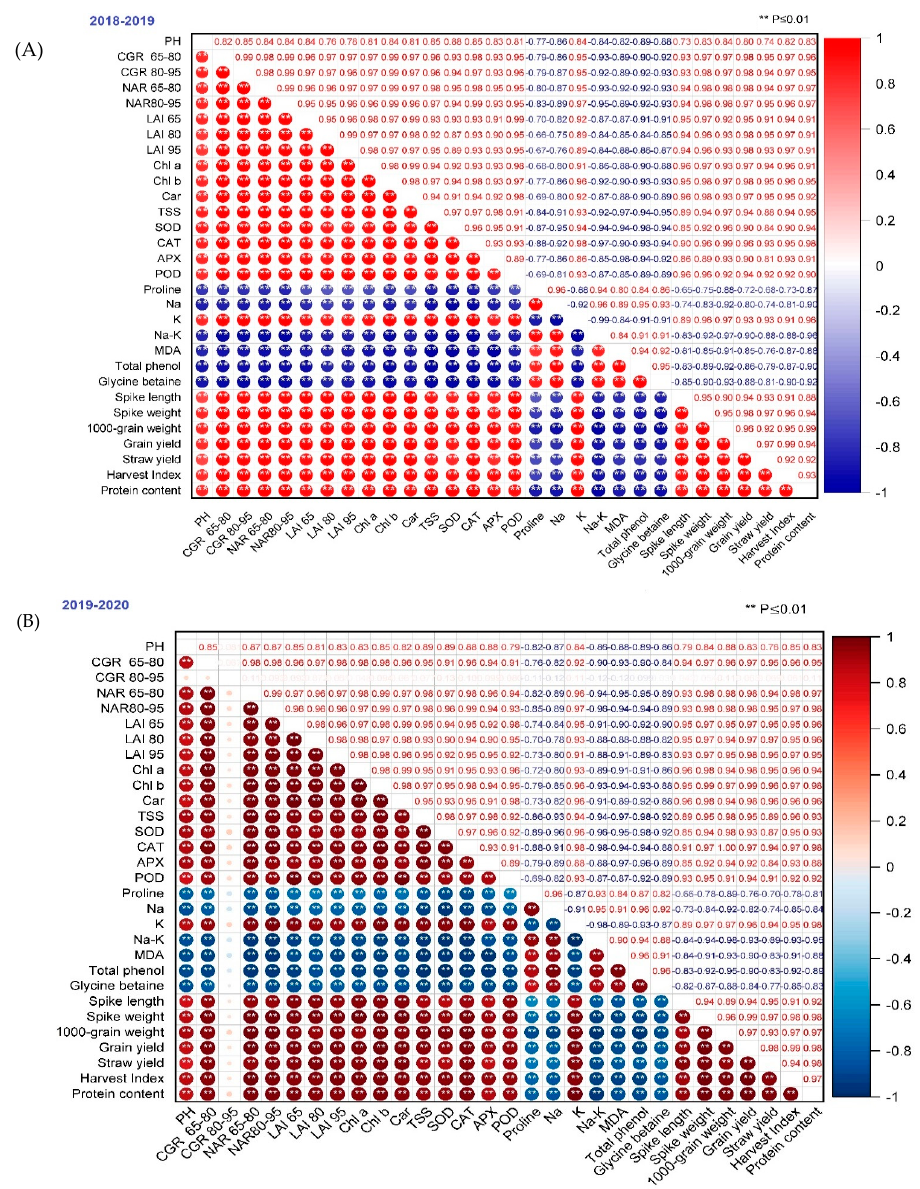
Figure 9. Correlation coefficients of wheat grain yield on growth, physiological traits, and yield components in the two seasons ( A ) 2018–2019 and ( B ) 2019–2020. According to the color scale, the darker positive scale represents most treatment responses, while the darker negative stripes show the least response. The dark red color shows a high positive association, and the dark blue shows a high negative correlation between traits. Similarly, as the color intensity decreases, the treatments show moderate performance in both the positive and negative ranges.